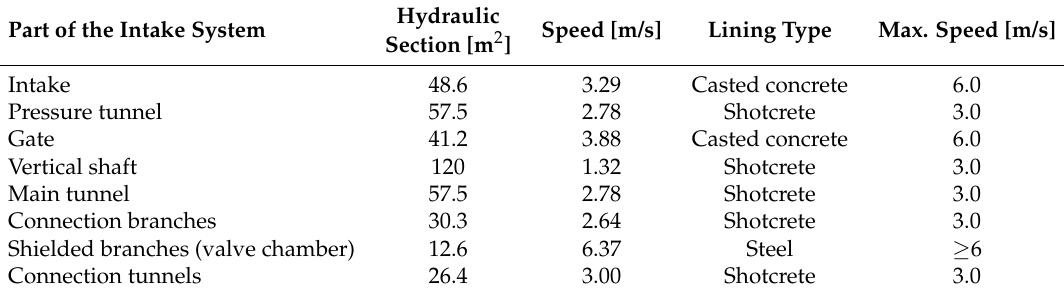
Table 1. Maximum speed for each part of the intake system.